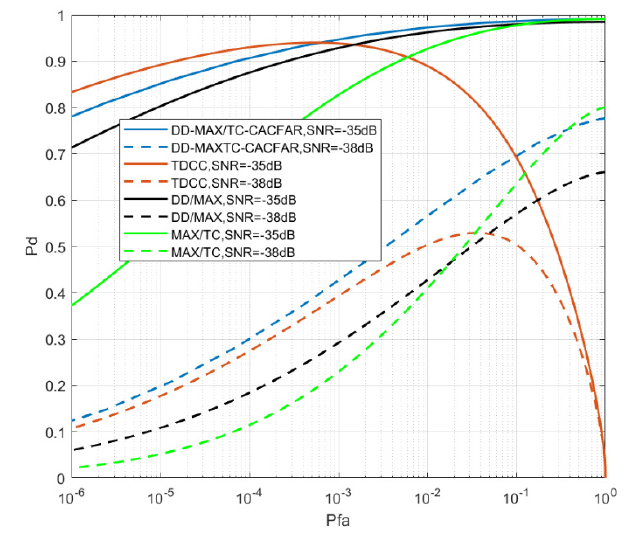
Figure 13. ROC Figure 13. ROC curves.